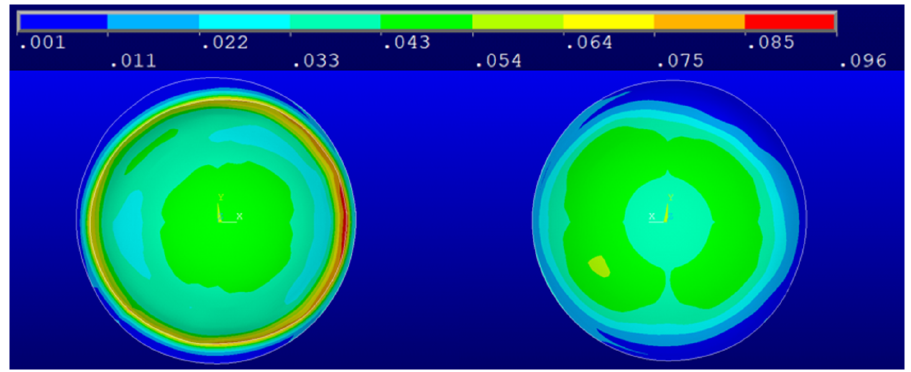
Figure 8. Von Mises Strain distribution in measurement phase for G0 geometry.